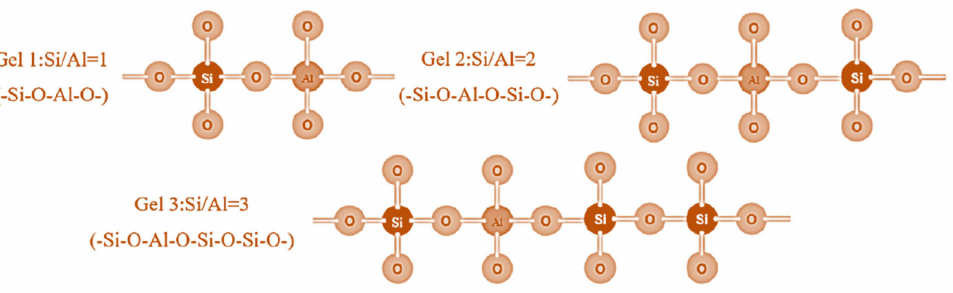
Figure 3. Geopolymer